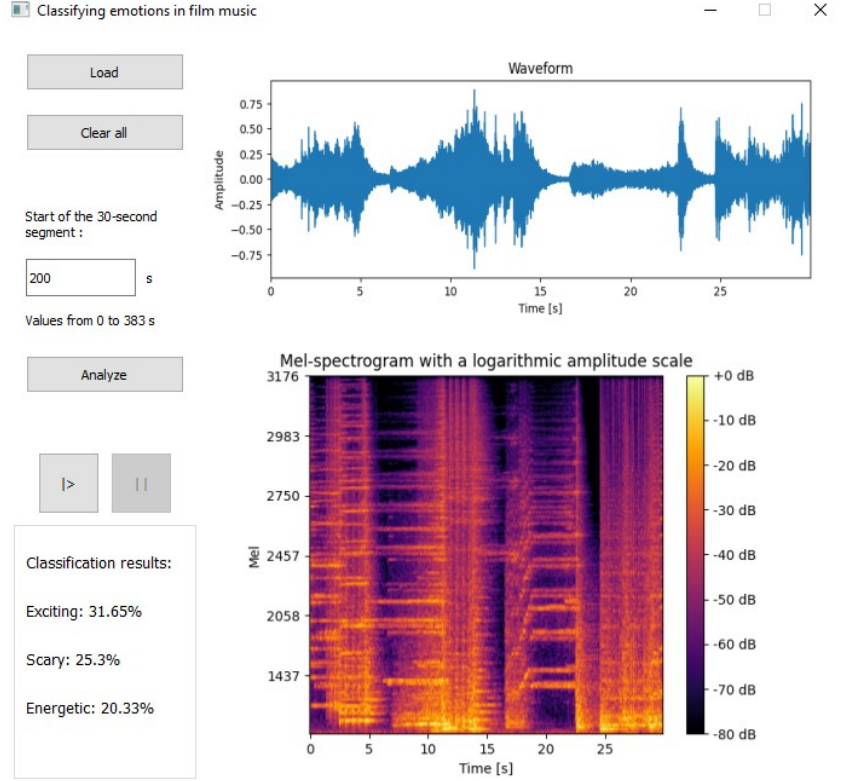
Figure 13. An example of the signal analysis and the classification results performed by the con- structed system. Results show that three similar classes of emotions, i.e., exciting, scary, and energetic, were assigned by the application to a particular film music excerpt.